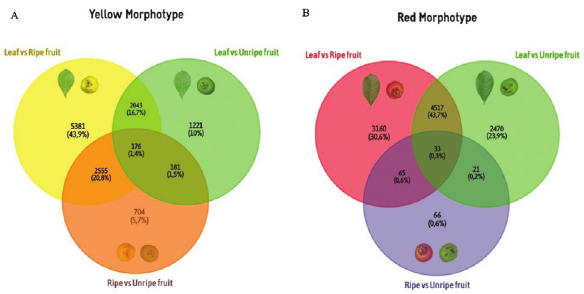
Figure 4 - Total number of differentially expressed clusters among the leaf and unripe and ripe fruits from the yellow and red morphotypes of P. cattleyanum .